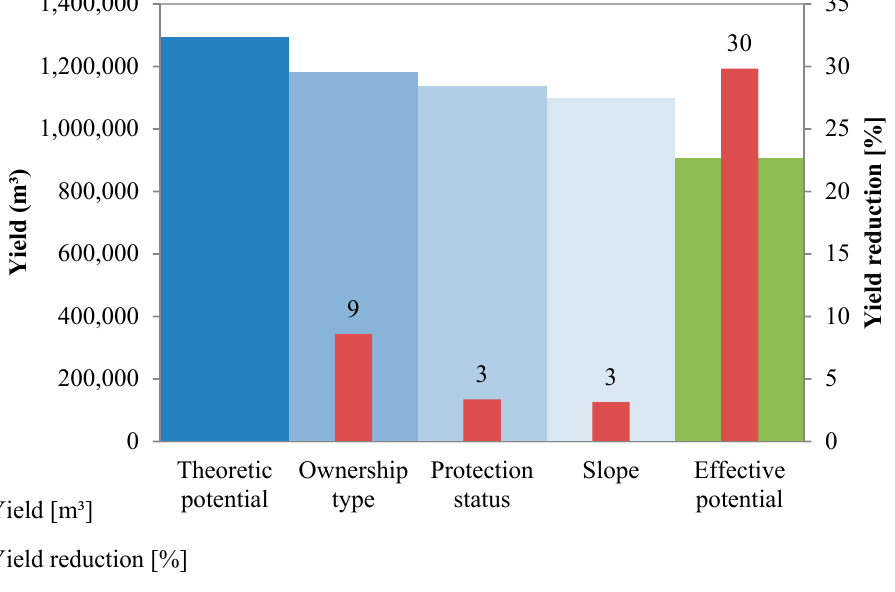
Figure 4. From theoretical to effective potential: site-specific attribute data reduce the yield of the model region (yield in m³ at time step